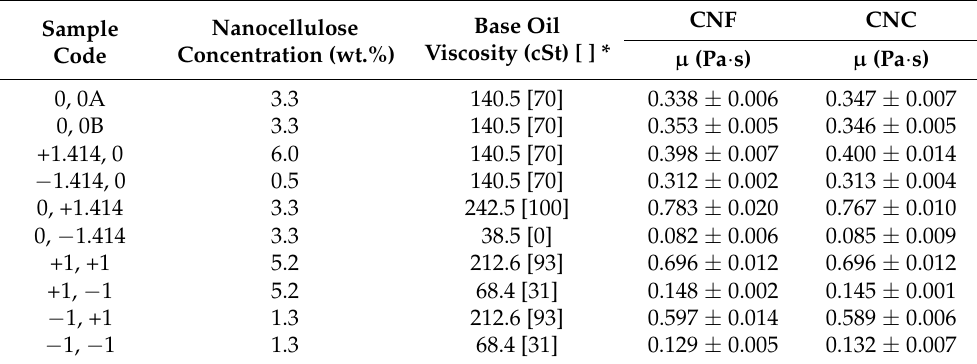
Table 1. Average dynamic viscosity values, at 25 ◦ C, for the CNF- and CNC-based